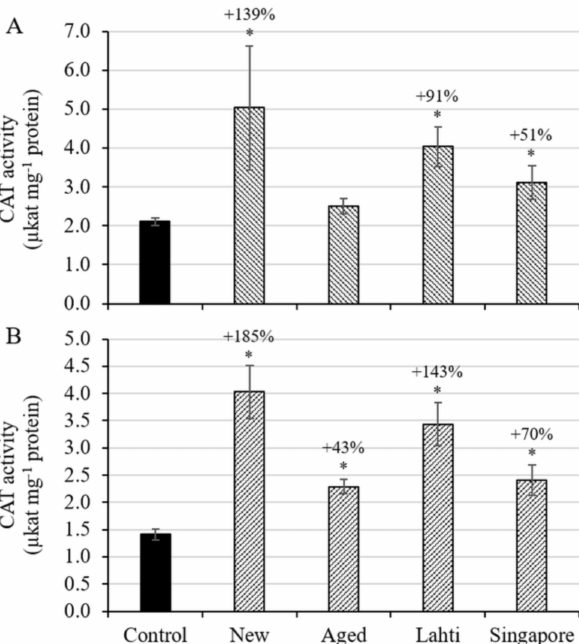
Figure 4. The catalase activity in roots ( A ) and shoots ( B ) of T. aestivum seedlings exposed to ≤ 4 mm microplastic particles from threaded bottle caps (new, artificial aged, collected in Lahti and Singapore) in the soil after seven days compared to controls without microplastic in soil. Data represent mean enzyme activities ± standard deviation. Statistical significance compared to the control is represented by an asterisk (*) where p < 0.05 ( n =